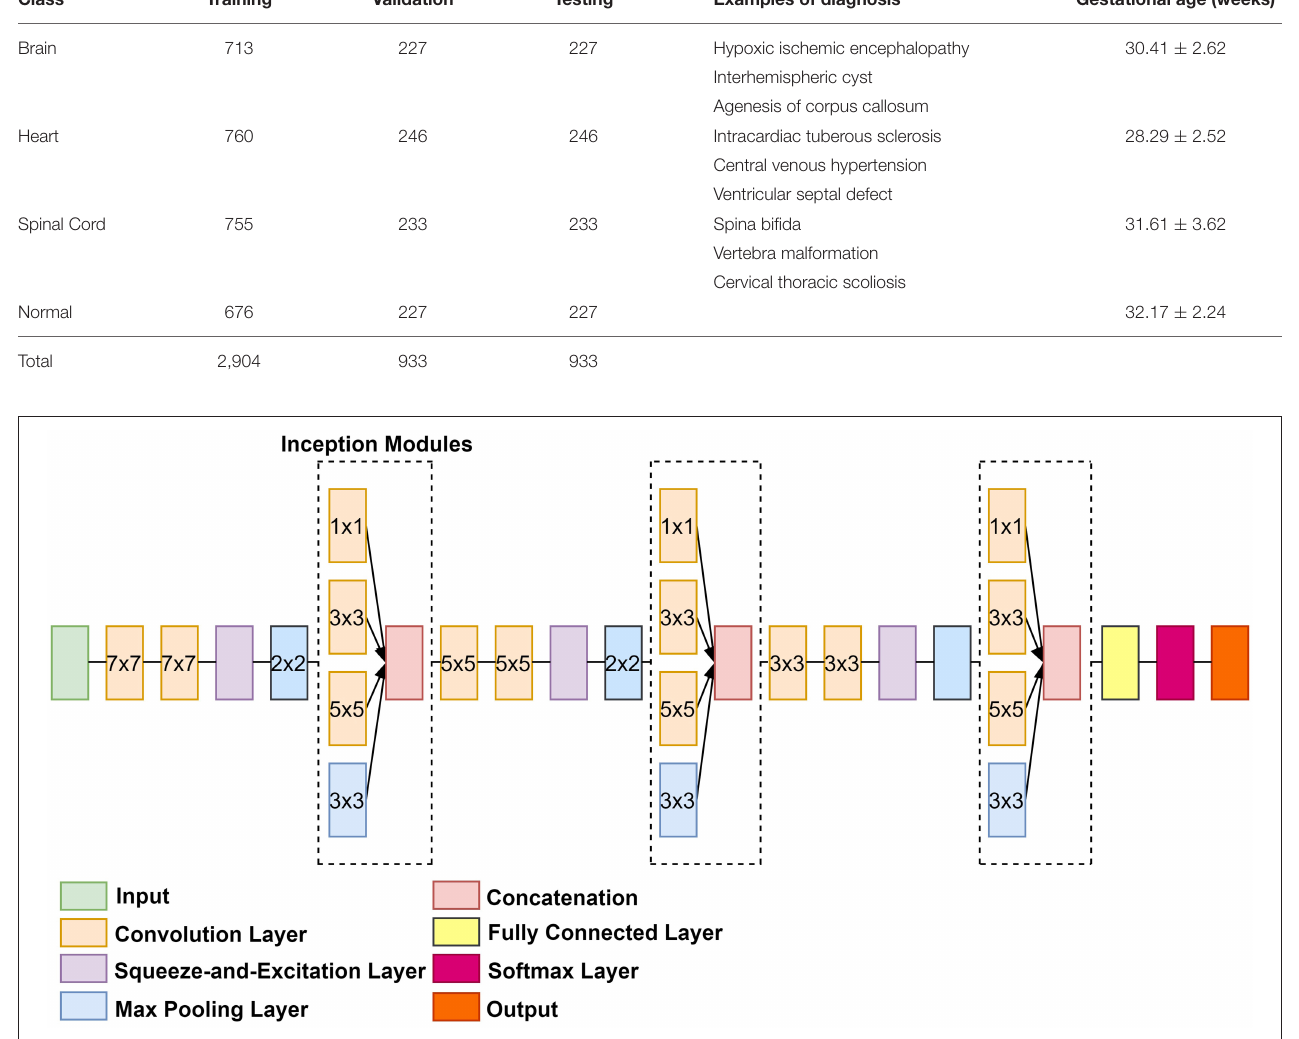
FIGURE 1 | An overview of the proposed classification architecture, FOAC-Net.